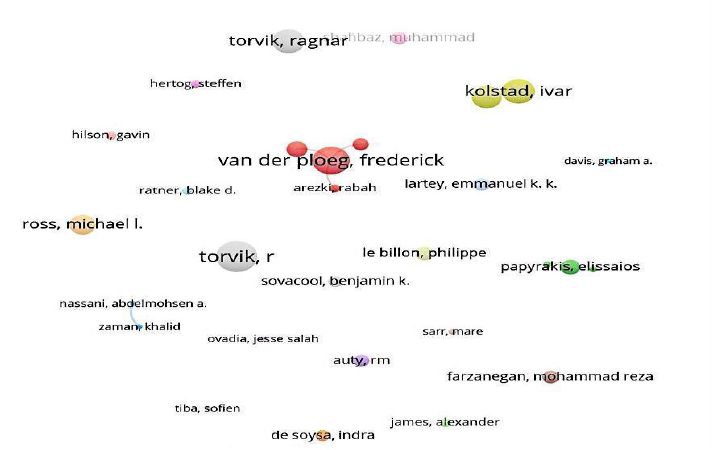
Figure 9. Comparison of the publication number by top30 countries, top 29 institutions, and top 29 authors (using VOSviewer).